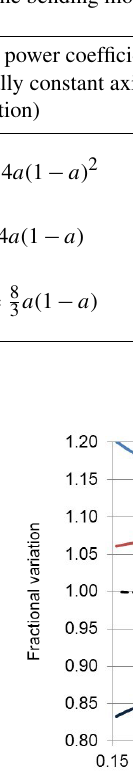
Table 1. Basic actuator disc equations for power, thrust and out-of-plane bending moment.